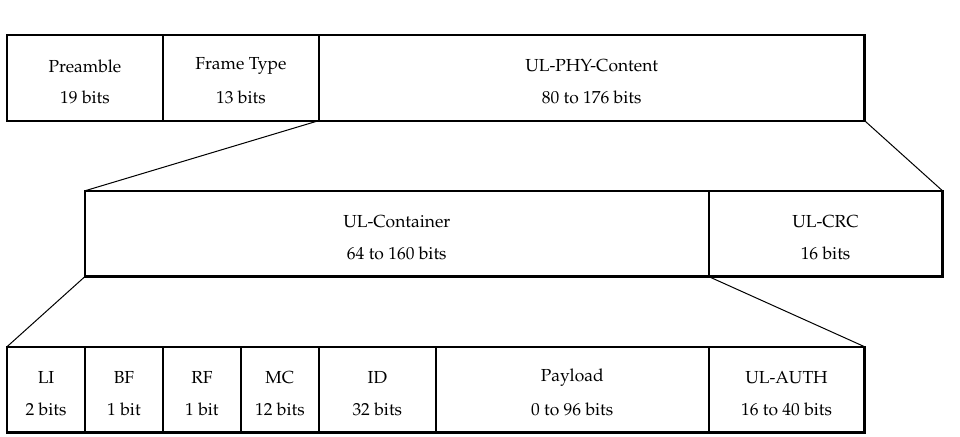
Figure 4. Uplink frame structure in Sigfox.